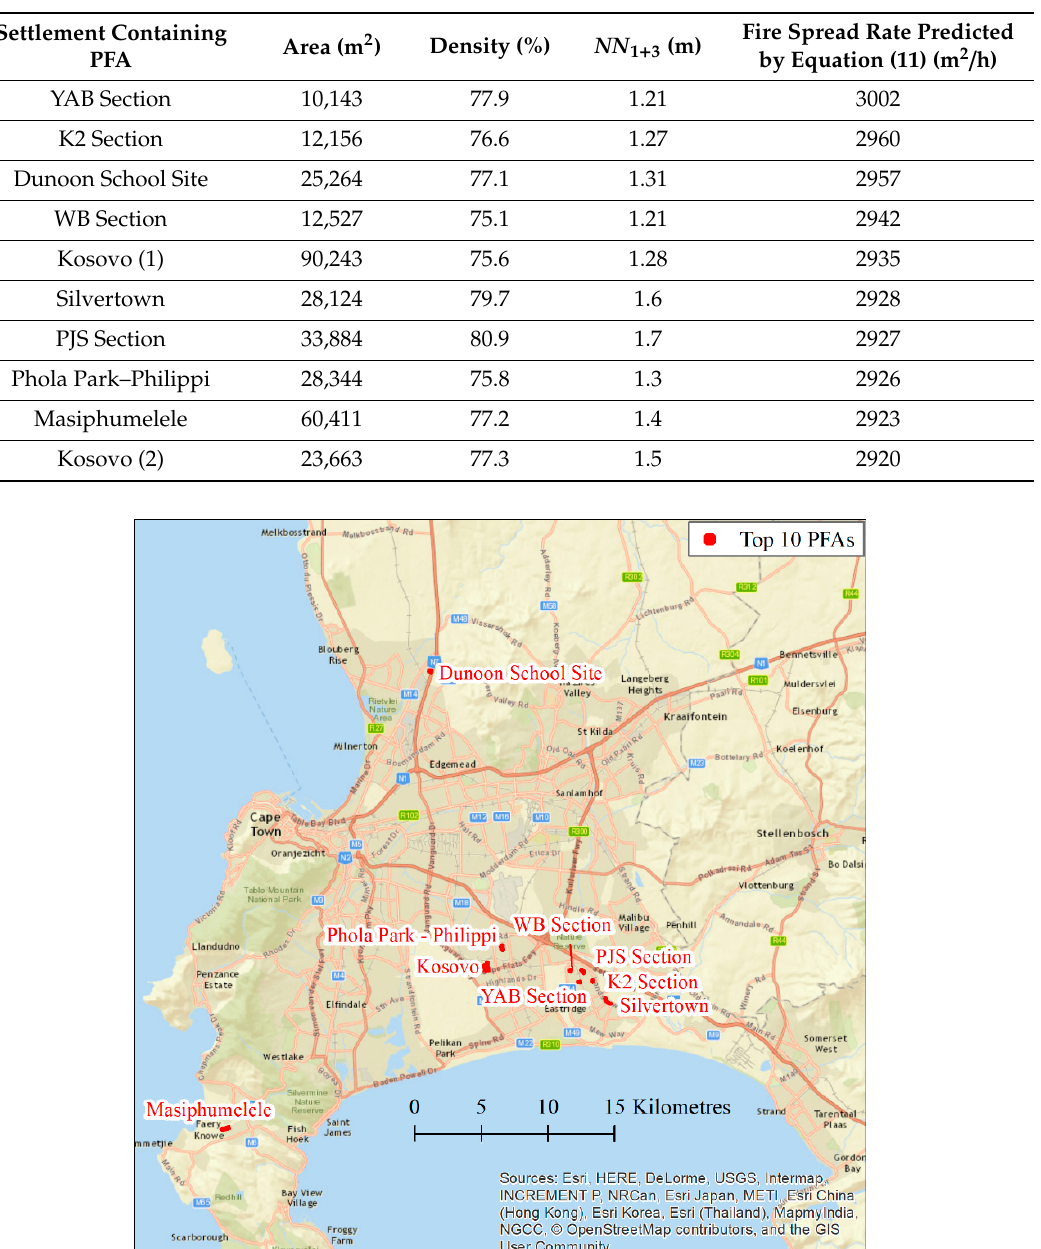
Figure 19. Location of the top 10 PFAs greater than 1 ha that have the highest fire spread rate (North is at the top of the images).